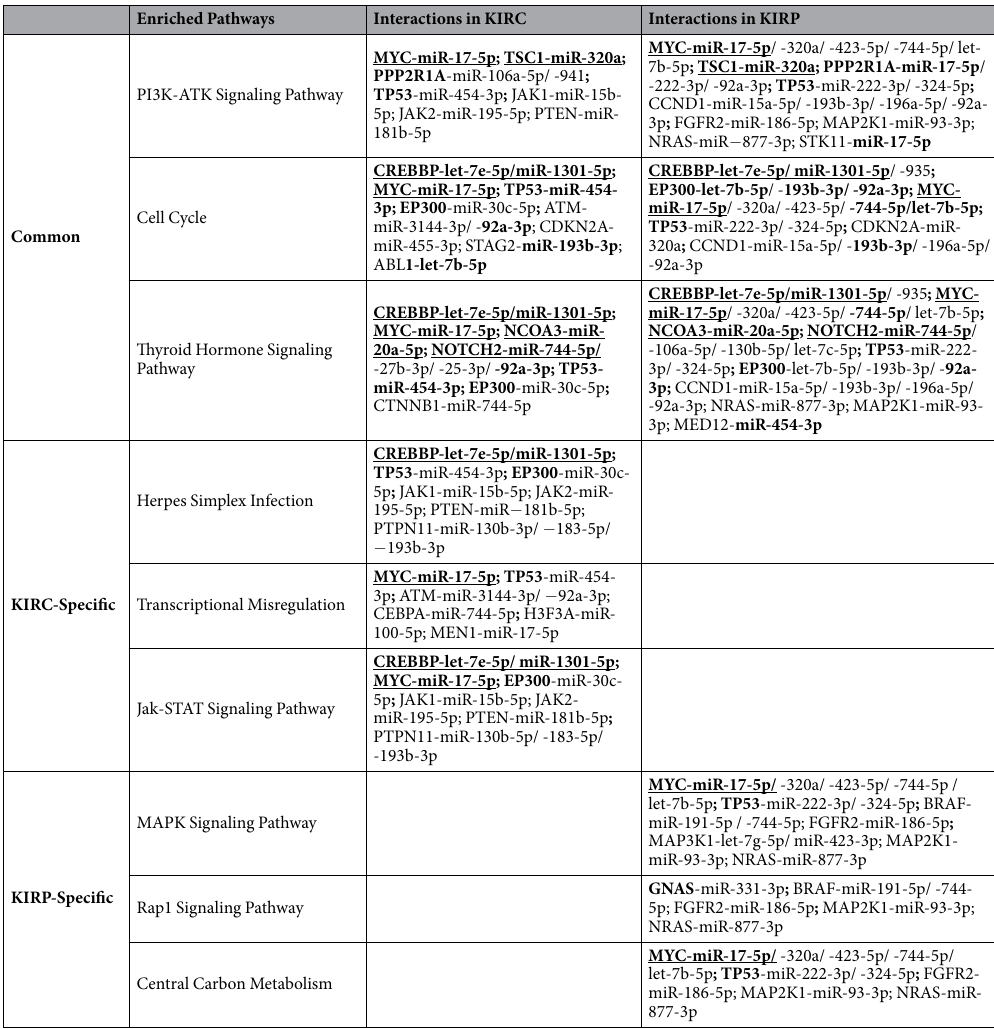
Table 1. Illustration of the common and cancer-specific pathways and the miRNA-mRNA interactions involved in KIRC and KIRP. * Underline indicates the common interactions between KIRC and KIRP and Bold denotes the same genes or miRNAs involved in KIRC and